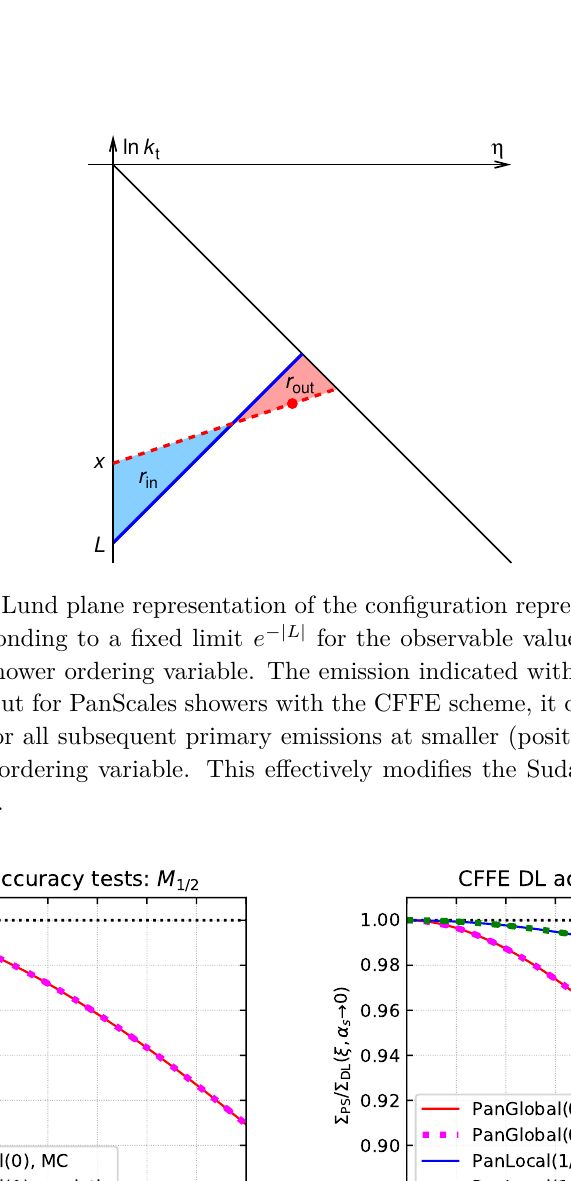
Figure 16. Demonstration that our analytical calculation of the DL discrepancy for the CFFE colour scheme, eq. (B.3), agrees with the full shower runs in the α 0 limit, as a function of s → (left) and M (right) observables. ξ = α s L 2 , showing the M 1 1 / 2